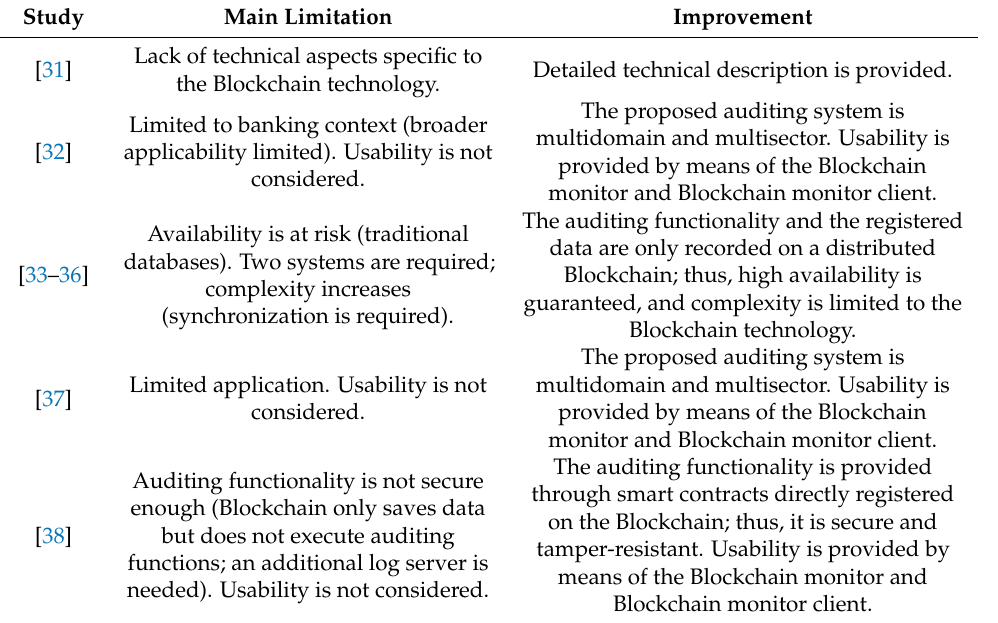
Table 4. Improvements over the state-of the-art Blockchain-based audit trail